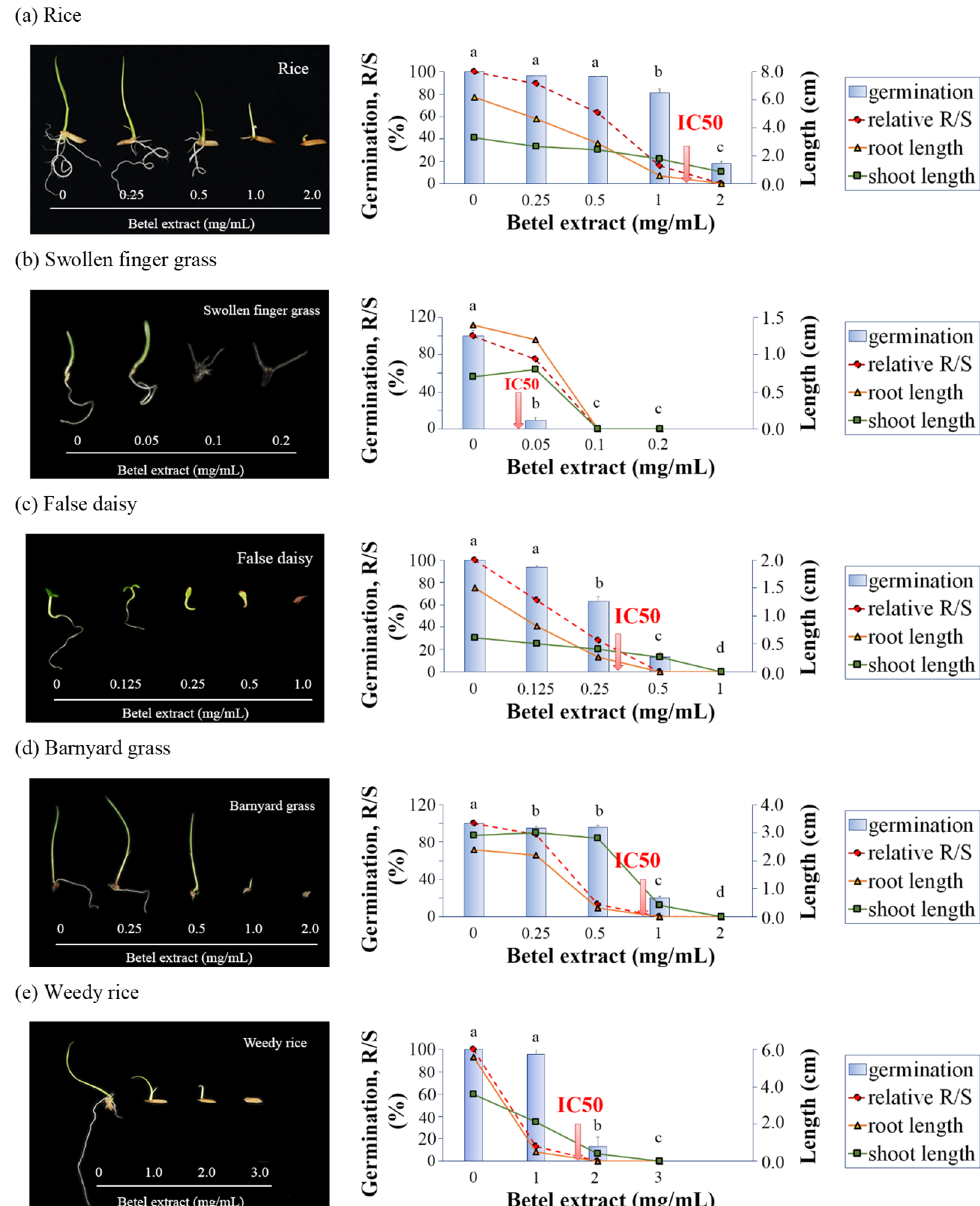
Figure 3. Effects of BE on seed germination and seven days after germination seedling growth by means of paper-plate assay. ( a ) rice ( O. sativa L.) ( b ) swollen fingergrass ( C. barbata Sw.) ( c ) false daisy ( E. prostrata (L.) L.) ( d ) barnyard grass ( E. crus-galli (L.) P. Beauv.) ( e ) weedy rice ( O. sativa f. spontanea Roshev.). The data in the graphs represented the photo of seedlings in the left panel. The arrows in the graphs indicated the IC 50 values for germination inhibition. Values are means ± SD of three replications ( n > 100). Different superscript letters on the bars indicated statistically significant differences of germination among different BE concentrations at p < 0.05.